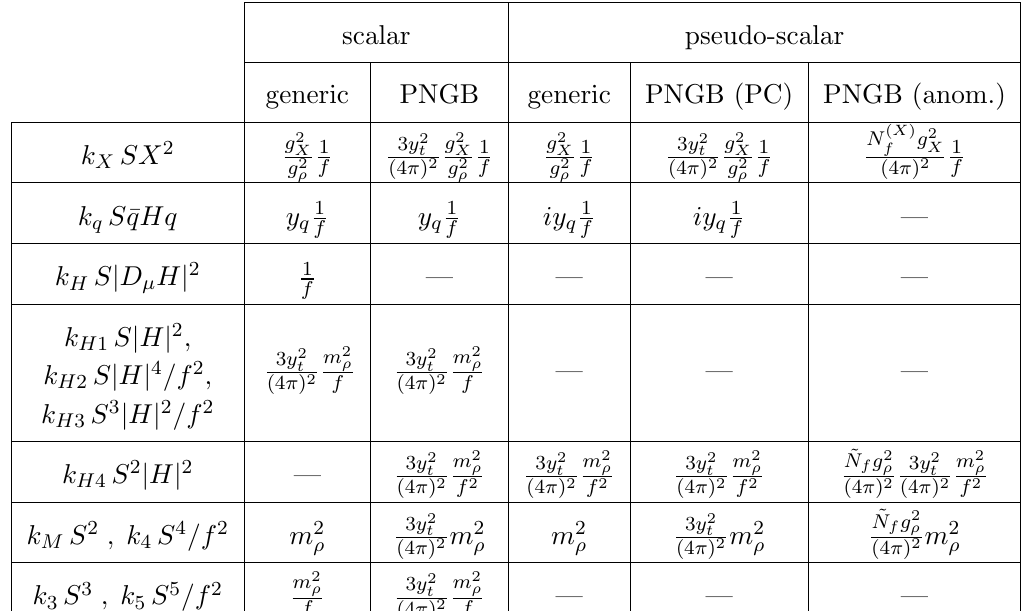
| Table 1 . Estimated size of the dimension-(cid:12)ve operators involving S corresponding to the scenarios described in the text. We do not list the operators for the inert scalar and pseudo-scalar since = (4 (cid:25) ) 2 . they are trivially obtained from the generic ones multiplying them by a loop factor N f g 2 (cid:26) X = G; W; B corresponds to SU(3) c , SU(2) L and U(1) Y gauge (cid:12)eld strengths, X 2 stands for either X i X i(cid:22)(cid:23) (for scalar S ) or X i X i(cid:22)(cid:23) (pseudo-scalar S ) while g X is a corresponding SM gauge (cid:22)(cid:23) (cid:22)(cid:23) e coupling, (cid:22) qq is a bilinear of SM fermions and y q is a corresponding SM Higgs Yukawa coupling. For PNGB pseudo-scalar with anomaly breaking N ( X ) are the coe(cid:14)cients of anomalies associated f to SM (cid:12)elds while ~ N f is a number of hyperquarks. The empty entries correspond to the operators which are either redundant or not expected to be generated in a given